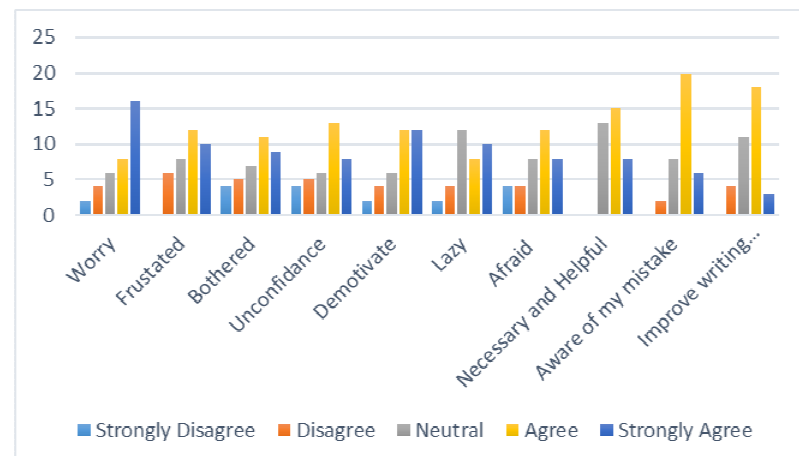
Figure 3. The mid-proficiency students’ emotional response to the use